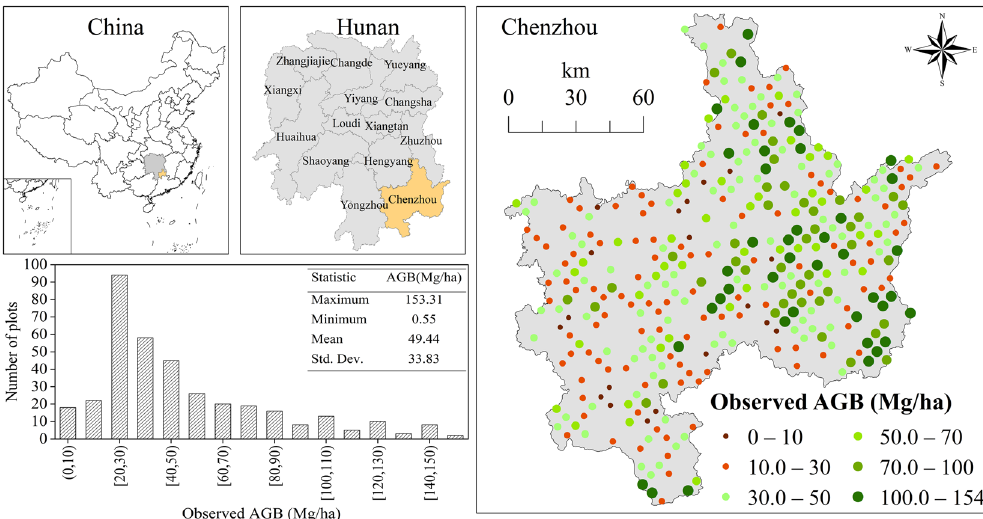
Figure 1. The location of the study area, including the distribution histogram of the observed AGB values of the field